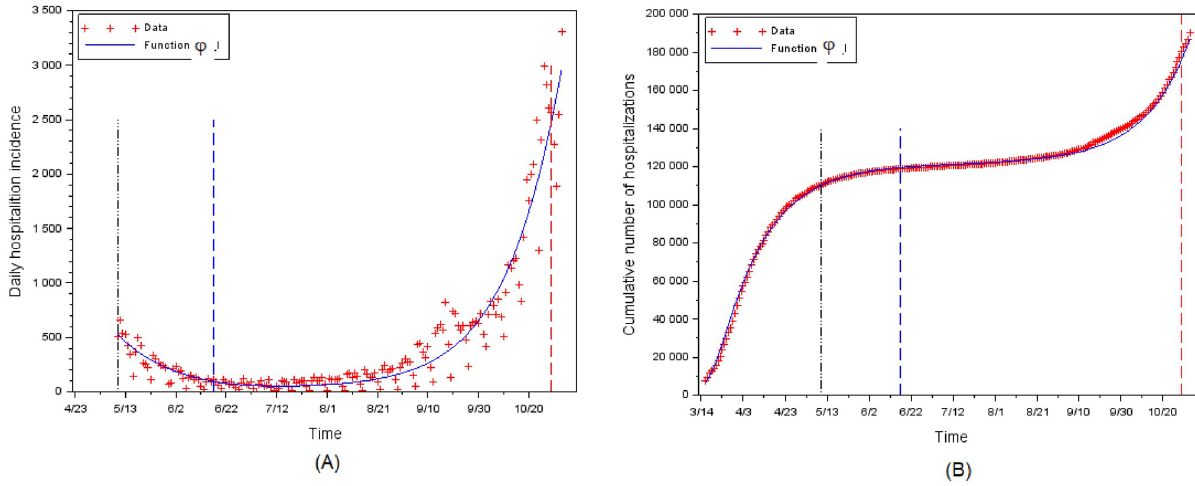
Fig 7. Calibration of daily hospitalizations. (A) Incidence. (B) Cumulative.